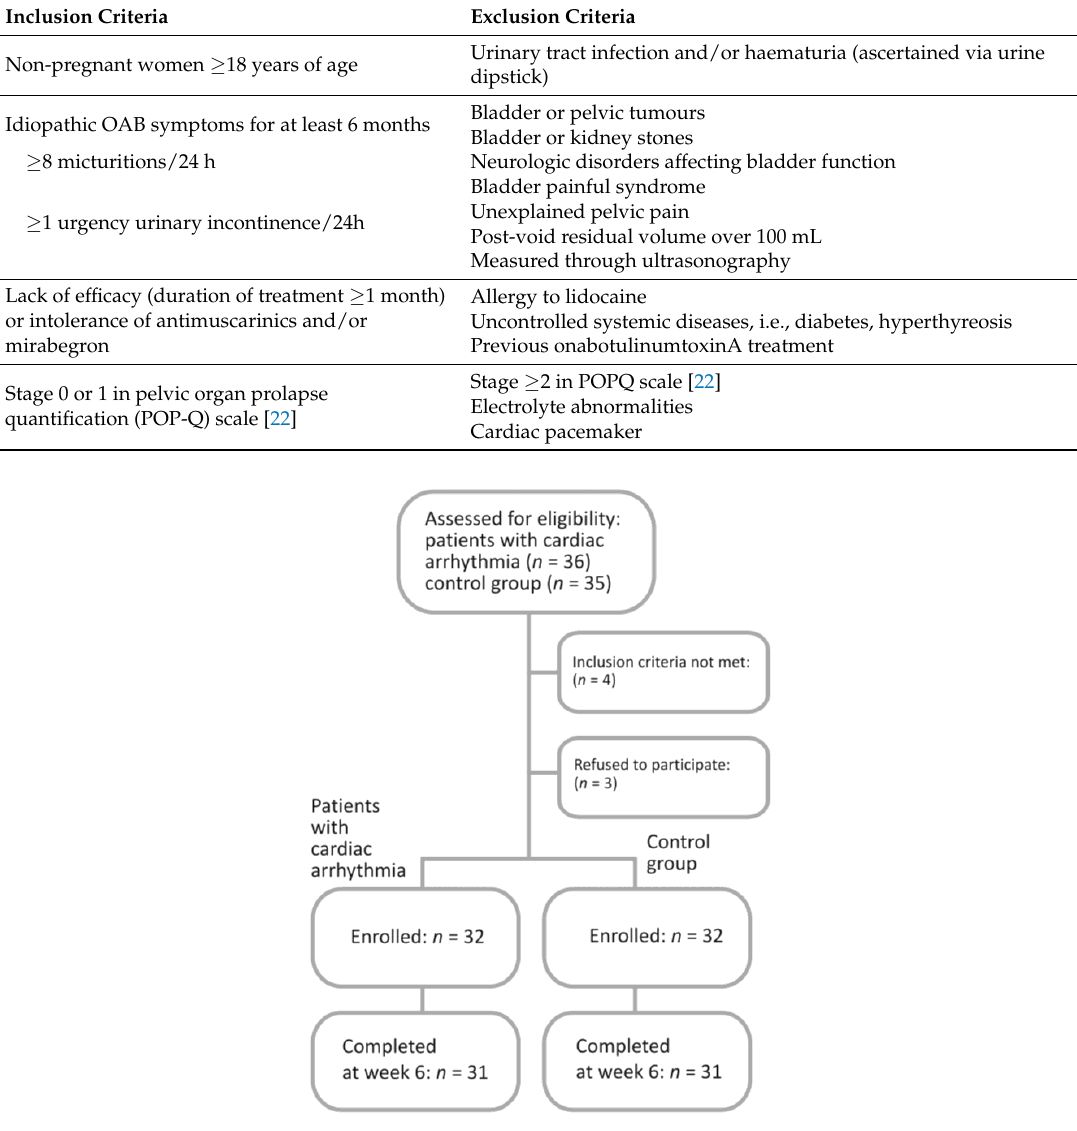
Table 1. Inclusion and exclusion criteria of the study for overactive bladder (OAB) patients.